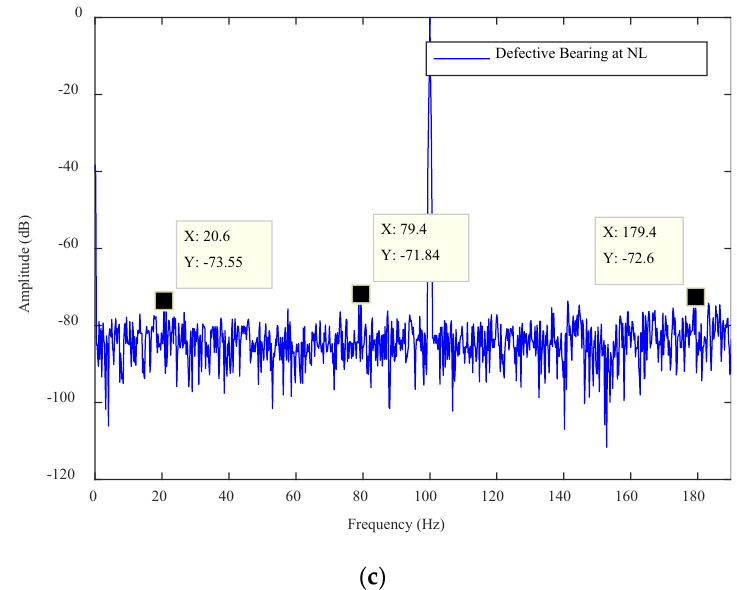
Figure 6. The NL plots for the ( a ) normal bearing, ( b ) type 1 defect and ( c ) type 2 defect.